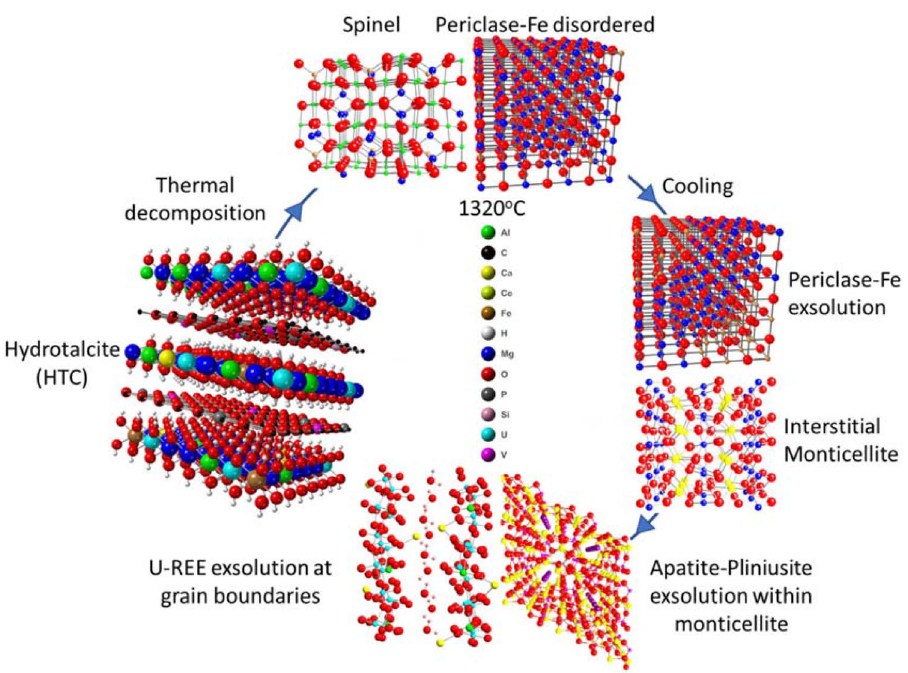
Figure 7. Visualization of polymetallic hydrotalcite (HTC) structure with mixed metal hydroxide layer and interlayer occupancy, its amorphisation/recrystallisation into ferropericlase and spinel followed by cooling with the interstitial crystallisation of monticellite, Fe exsolution in the periclase host, and the exsolution of both apatite-pliniusite within monticellite and a U-REE phase along periclase and spinel intergranular